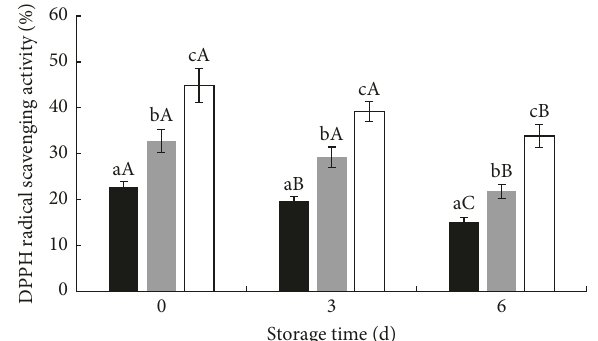
Figure 4: Changes in DPPH radical scavenging activity in a 6-day storage test of the emulsions with different oil contents ( oil: 5 g/ 100g; oil: 10 g/100g; oil: 20g/100g). Different lowercase letters above bars indicate significant differences among samples of dif- ferent oil contents, and different uppercase letters above bars in- dicate significant differences among samples of different storage times ( p < 0 .